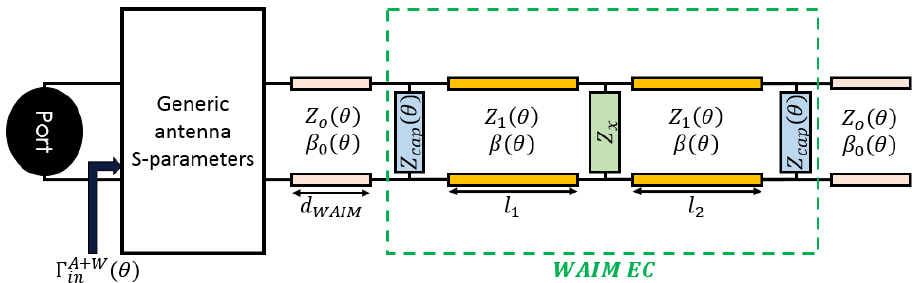
Figure 6. Global EC: antenna S-Parameters plus space between antenna and WAIM plus WAIM EC .